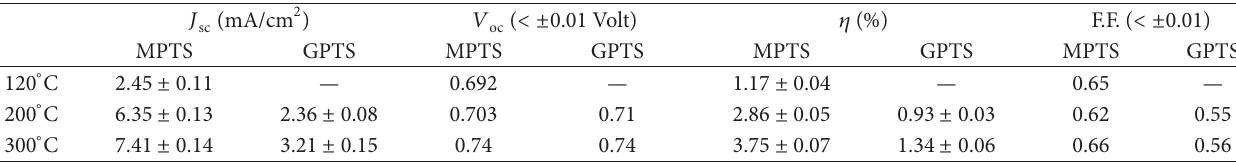
T 1: e DSC performance parameters for GPTS- and MPTS-modi�ed TiO at different